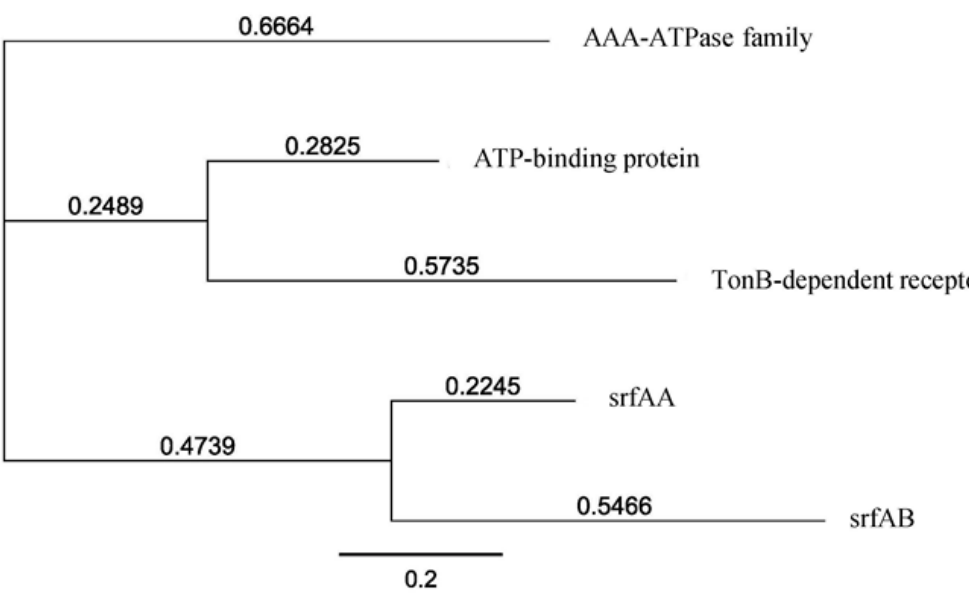
Figure 4. A phylogenetic tree of predicted amino acid sequences of surfactin synthase (srfAA and srfAB) and homologs of the obtained PCR products (AAA-ATPase family, ATP-binding protein, and TonB-dependent receptor) constructed using Genious Pro sequence analysis software version 4.7.6 (Michigan, IN, USA).